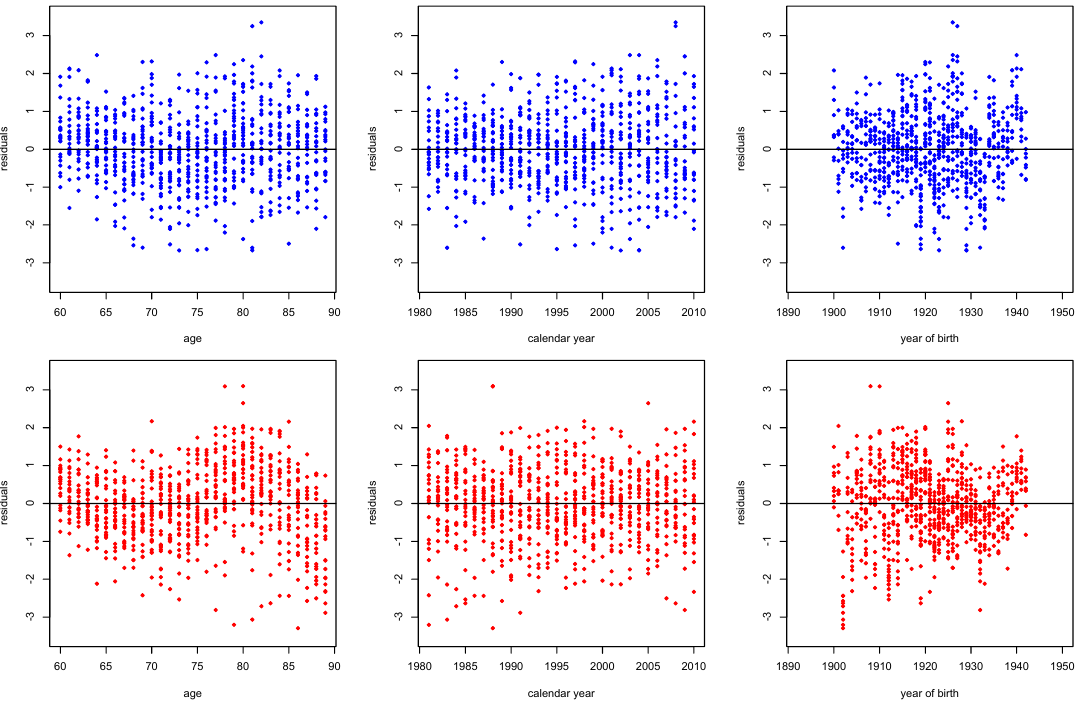
Figure 12. Residuals deviance of M 5 for males ( top panels) and females ( bottom panels) in Greece. Period 1981–2010, ages